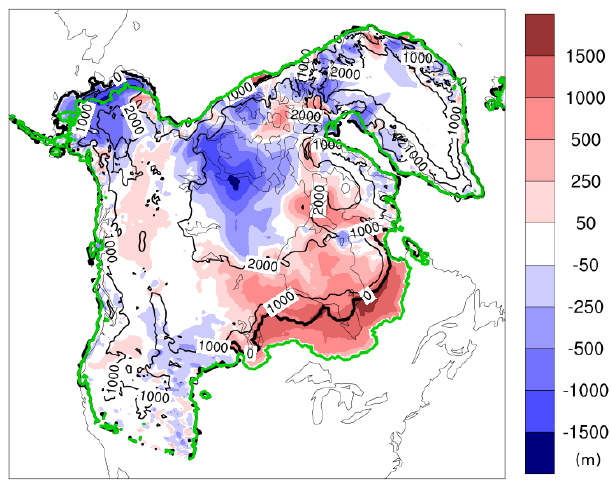
Figure 4. Impact of advective precipitation downscaling inclusion in the coupled model; NA ice thickness difference at 110ka between simulations with and without the advective precipitation method. Contours show the ice thickness in the control run. Thick black and green contours show the ice margin in the control and advective precipitation run, respectively. LOVECLIM parameters are set to default